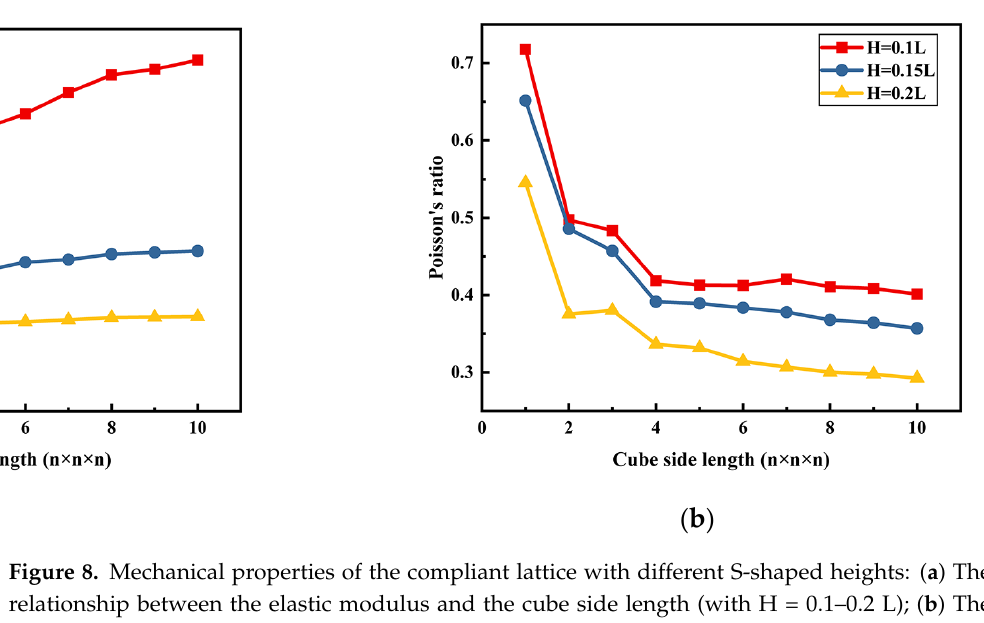
Figure 7. The deformation mechanism diagram and one of the geometric parameters of the compli- ant unit cell: ( a ) Deformation mechanism of the compliant cell under an external load; ( b ) Different S-shaped bulge heights of the compliant cell (L = 70 mm).